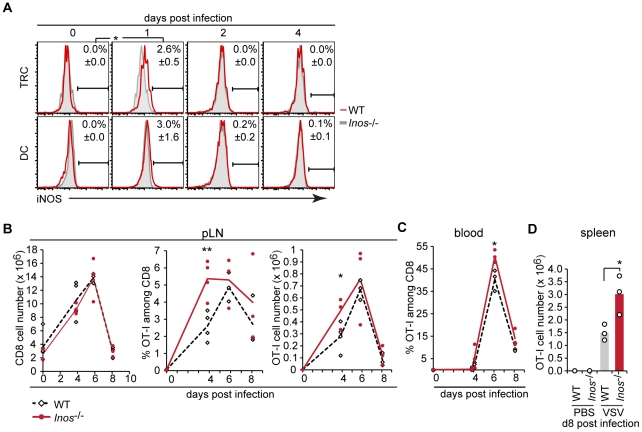
Lack of iNOS in vivo leads to increased an primary T cell response after viral infection.(A–D) WT or Inos
−/− mice were retro-orbitally grafted with 100'000 splenocytes from OT-I transgenic mice one day prior to subcutaneous infection with VSV-OVA. Draining pLN, blood or spleen from infected mice were harvested at the indicated time points after infection and cell suspensions generated by using collagenase digestion (A) or by mechanical homogenization (B, D). (A) Intracellular iNOS protein expression in TRC (gp38+CD45−CD31−CD35−) or DC (CD11c+MHCII+CD45+) as analyzed by intracellular flow cytometry. Representative histograms show the percentage (± standard deviation) of iNOS expressing TRC (top) and DC (bottom) in WT versus Inos
−/− mice. (B) The graph on the left side shows the total CD8+ T cell numbers, the graph in the middle the percentage of OT-I T cells among the CD8+ T cells and the graph on the right side the total OT-I number in pLN (pool of 6 draining LN). No significant difference was observed in total LN cell numbers between immunized WT and Inos
−/− mice (not shown). (C) Shows the percentage of OT-I T cells among the CD8+ T cells in the blood, (D) shows the total number of OT-I T cells in the spleen. (A–D) n≥3, 1 out of 2 independent experiments is shown. * P<0.05, ** P<0.01, *** P<0.001.